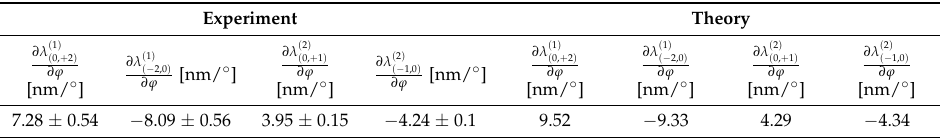
Figure 9. Measured and calculated shift of the side-peaks in the spectra of FBGs in respect to the position of the central peak ( a ) and the separation of the inner and outer pair of side-peaks ( b ). Experimental results are marked with circles. Table 1. The slopes of straight lines Δλ ( ϕ ) fitted to experimental and theoretical data of the side-peaks’ shift. Fitting errors are given only for experimental data.